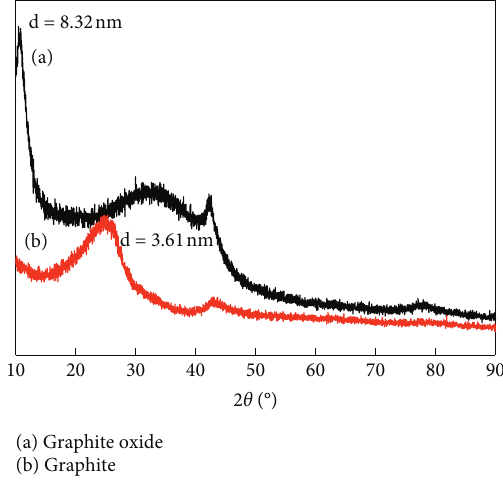
Figure 2: XRD patterns of GO and graphite.